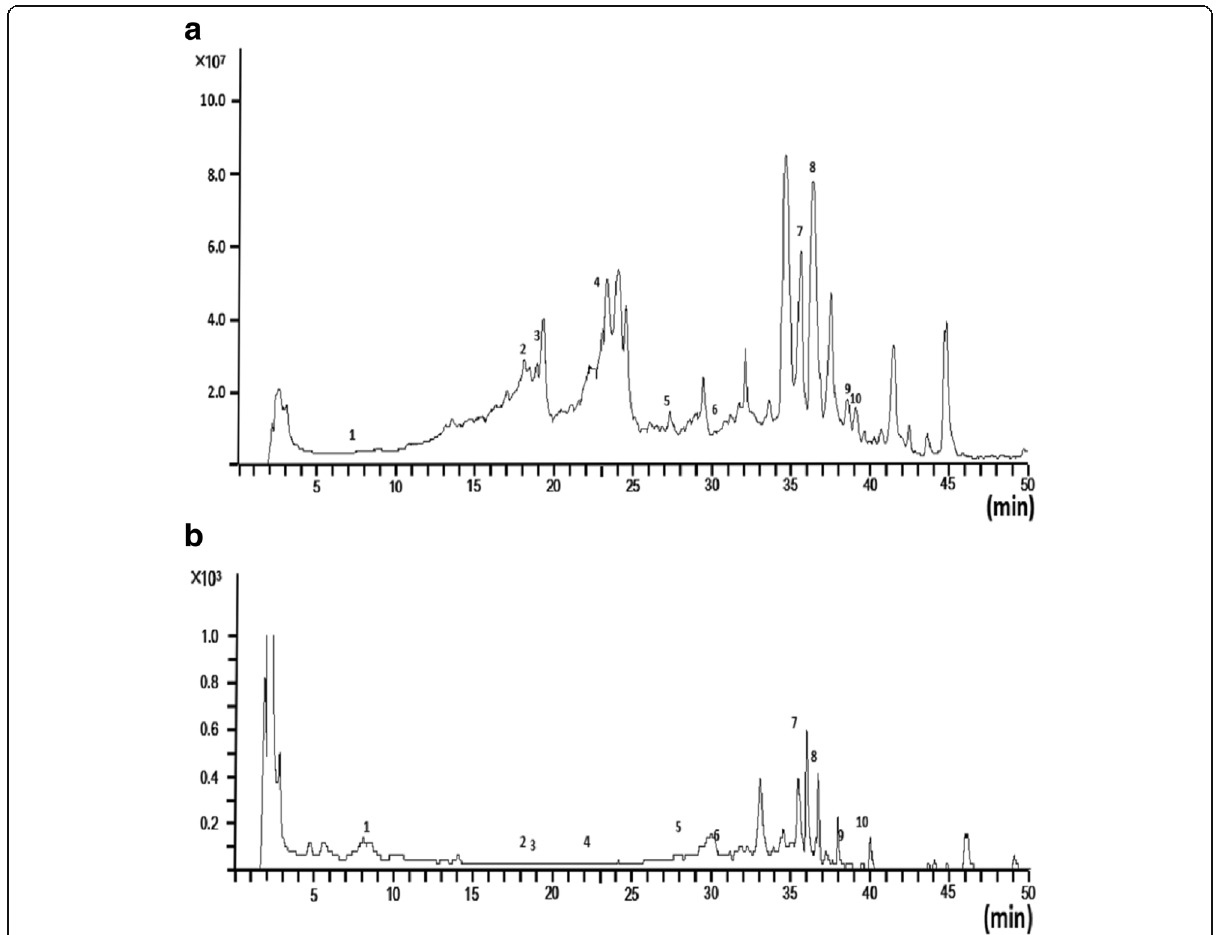
Fig. 3 TIC chromatogram and VU chromatogram of the extract of DHFZT in positive ion mode. ( a ) total ion current chromatogram, X-axis repre- sents the retention time (min),Y-axis represents ion intensity; ( b ) ultraviolet chromatogram, X-axis represents the retention time (min), Y-axis represents mAU